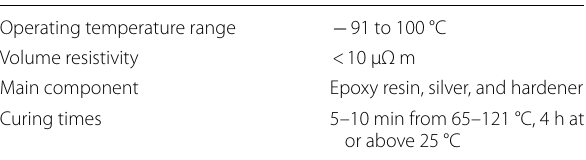
Table 1 Physical properties of conductive epoxy adhesive